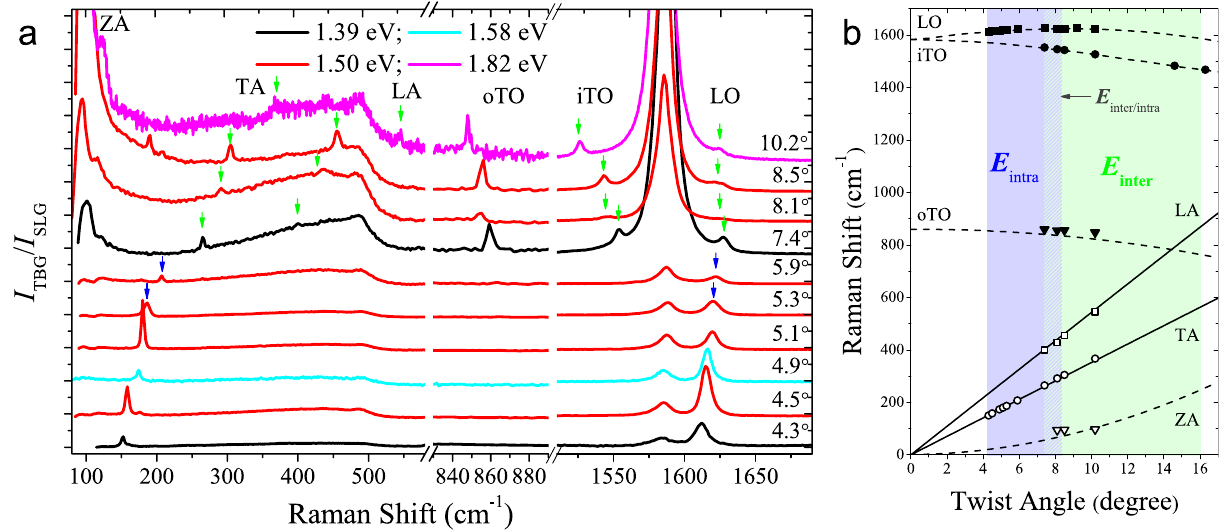
Figure 1. ( a ) Raman spectra of ten TBG samples with different angles between 4.3 ◦ and 10.2 ◦ . The spectra were acquired using four different laser lines, represented by different colours in the figure, but only those presenting the strongest resonance effect are displayed in the figure. The spectra is shown in three regions: (i) the acoustic modes (ZA, TA and LA), (ii) the out-of-plane TO phonon (oTO) and (iii) the optical modes close to the G 7.4 10 band (iTO and LO). All spectra with θ in the acoustic and the oTO regions for ◦ were multiplied by ≥ × a better visualisation. ( b ) Positions of all peaks extracted from all Raman spectra plotted as a function of θ . The twisting angles were determined by the LA and TA phonon branches according to dispersion curves (full black lines) obtained by Cong et al. 29 (see text). The dashed black lines are theoretical curves of the TBG phonon frequencies 27 as a function of the twisting angle 28 . The blue (green) stripe highlights the range of angles of the TBGs investigated in this work that are activated by the intralayer (interlayer) el–ph